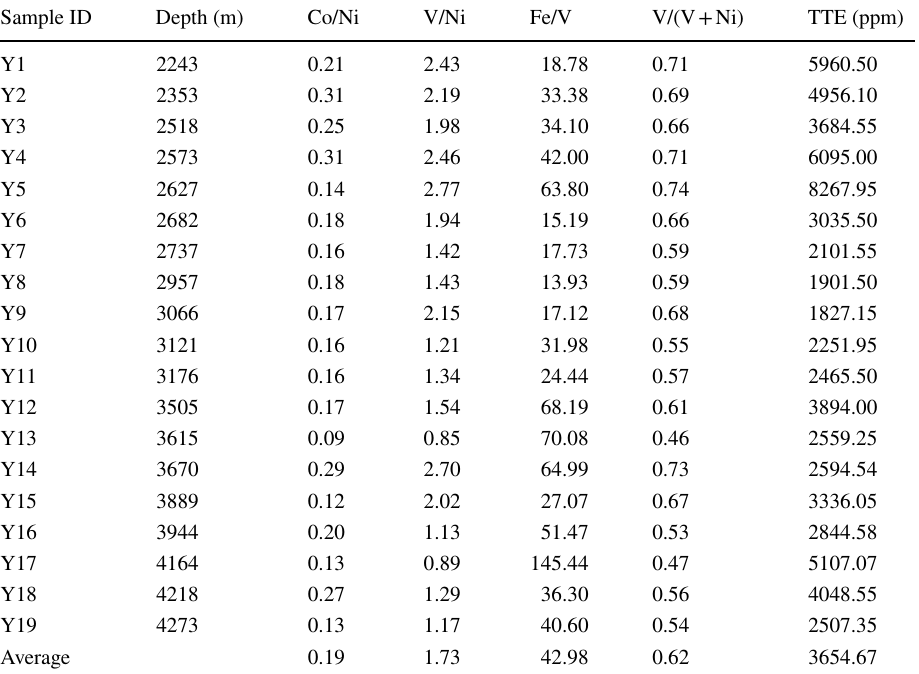
Table 4 Geochemical parameters for kerogen samples from Well